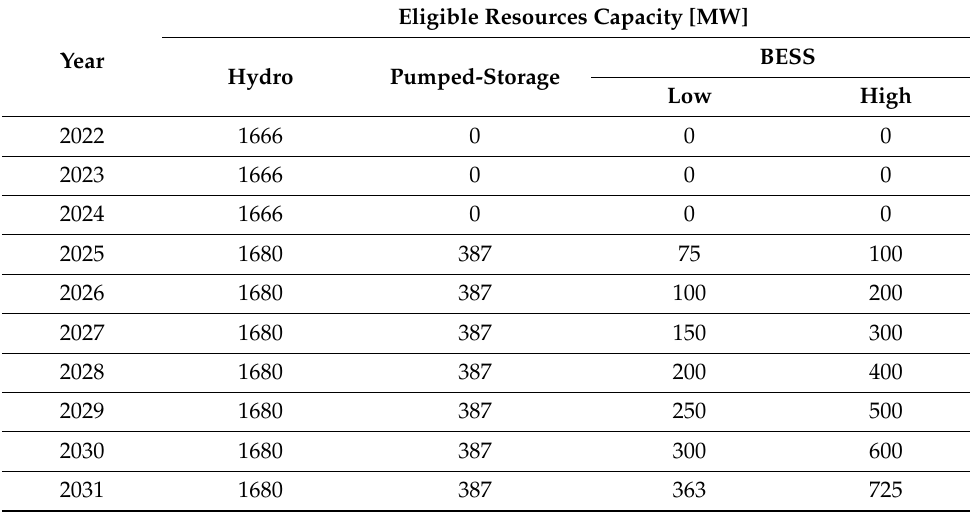
Table A2. Eligible resources capacity.